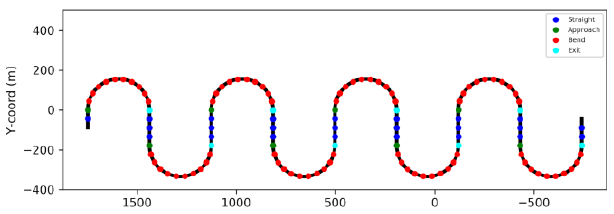
Figure 2. Bird’s-eye view of the track layout. Dots indi- cate the locations where the targets and distractors were displayed. Blue dots indicate presentation on the straights, red dots during steady-state cornering, and green and cyan dots the transitional entry and exit phases (which were not analyzed due to the small number of